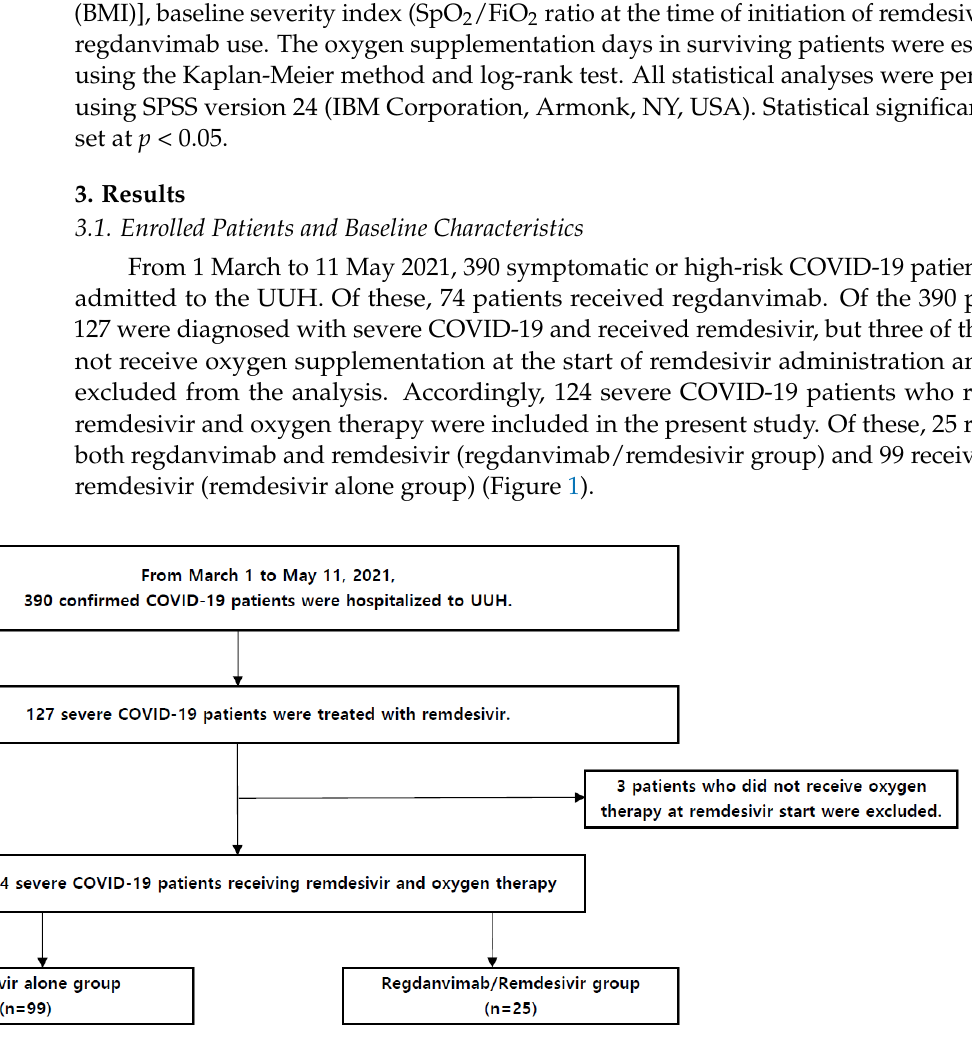
Figure 1. Flowchart of the present study. 390 symptomatic or high-risk COVID-19 patients were hospitalized to UUH from 1 March 1 to 11 May 2021. Of these, 74 patients received regdanvimab. Among 390 hospitalized patients, those receiving remdesivir were selected ( n = 127). Remdesivir was administered to severe COVID-19 patients with pneumonia (determined via chest imaging) and room air SpO2 ≤ 94%. Three patients were excluded from the study because they did not receive oxygen therapy at the start of remdesivir administration, and finally, 124 severe COVID-19 patients were selected for the current study. Of these, 99 patients were administered only remdesivir, and 25 patients were treated using regdanvimab before remdesivir administration. Regdanvimab was used when room air SpO2 > 94% and chest imaging showed pneumonia, over the age of 60 years, or those with underlying diseases (cardiovascular disease, chronic lung disease, diabetes mellitus, or hypertension). Among the patients who were treated with regdanvimab, remdesivir was administered owing to the change in status to severe COVID-19 during hospitalization. Abbreviations: COVID-19, coronavirus disease 2019; UUH, Ulsan University Hospital; SpO2, pulse oximetric